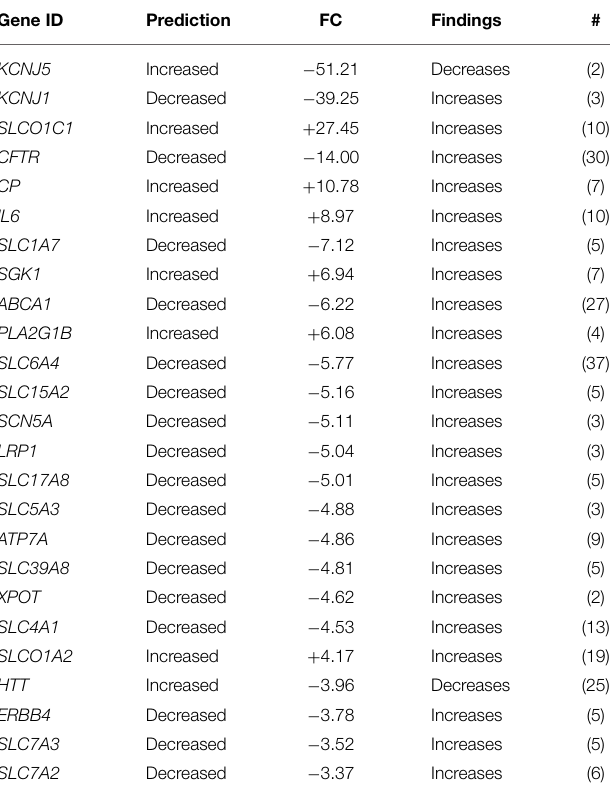
TABLE 6 | Top 25 changed genes annotated to Transport of Molecule based on fold change (both up/down-regulated genes). Gene